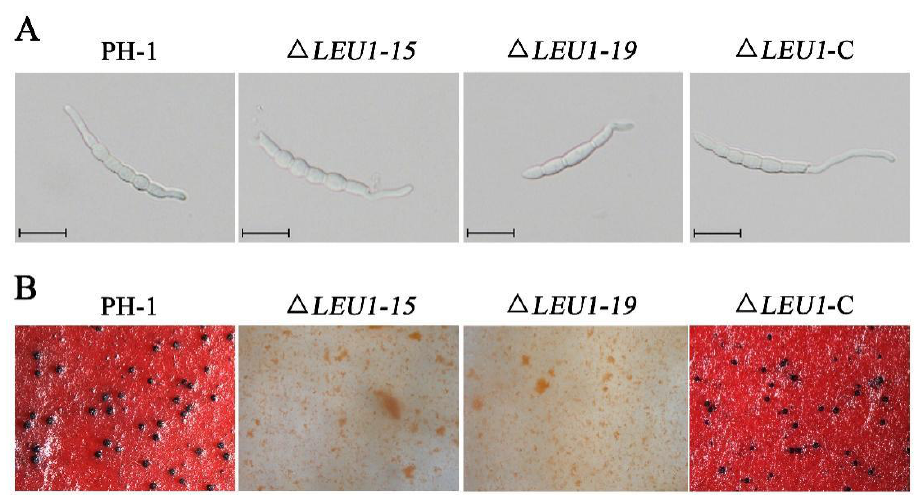
Figure 3. Conidial germination and sexual reproduction of FgLEU1 deletion mutants. ( A ) All strains were incubated in liquid YEPD for 4 h at 25 °C with 180 rpm and examined for germination. Scale bar = 20 μm. ( B ) Sexual development of the strains. Perithecia were visualized as black structures on carrot agar plates. Photographs were taken at 21 days post self-fertilization. All experiments were repeated three times with three replicates at each time.